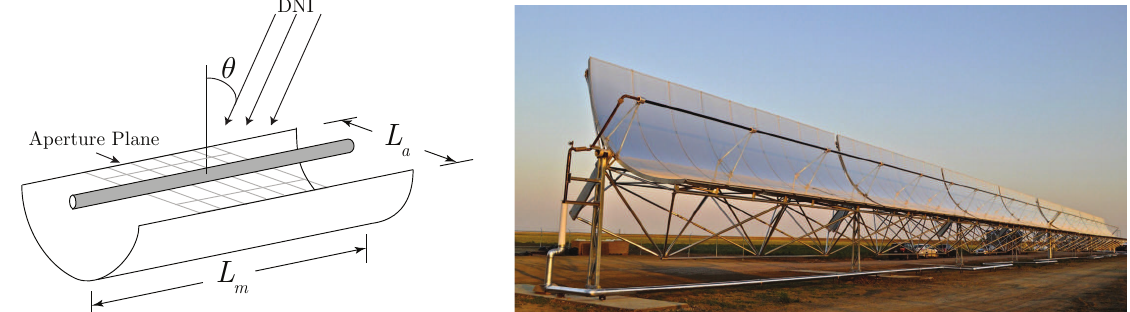
Figure 1. ( left ) An illustration of a parabolic trough solar concentrator (PTC) with the defined array length L m , aperture length L a and the aperture plane with incident solar radiation. ( right ) The large-aperture PTC (Skyfuel, Lakewood, CO, USA) powering a solar thermal desalination pilot by Stuber et al.